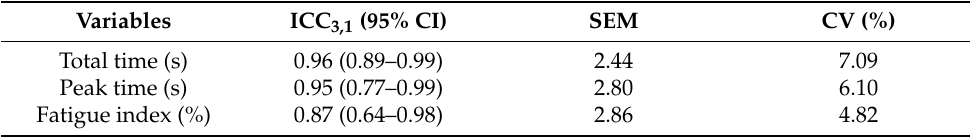
Table 2. Reliability analysis for the measured performances.